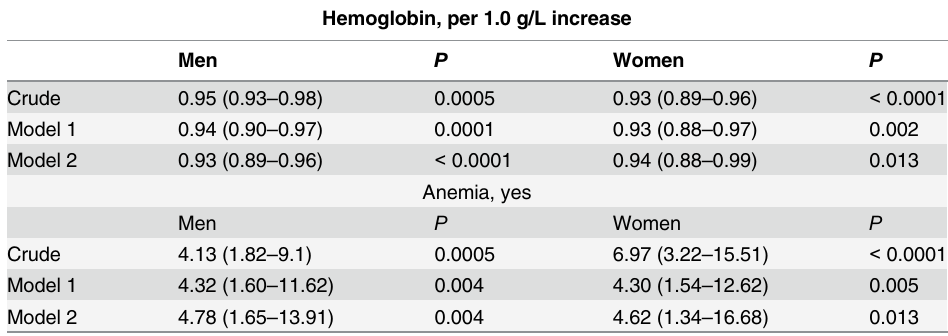
Model 1 is adjusted for age, duration of diabetes, systolic blood pressure, hemoglobin, hemoglobin A1c, urinary albumin-creatinine ratio at baseline and the use of rennin-angiotensin system inhibitors. Model 2 includes all variables in Model 1 plus body mass index, total cholesterol, logarithm of triglycerides, uric acid, creatinine, smoking status, and the use of statin. Smoking status was de fi ned as nonsmoker (= 0), previous smoker (= 1), or current smoker (= 2), and the use of rennin-angiotensin system inhibitors or statin was de fi ned as without (= 0) or with (=